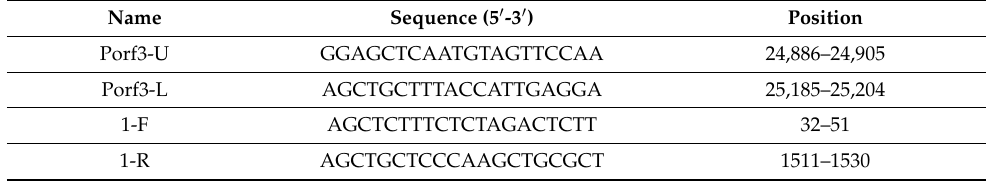
Table 1. Primers used for identifying and sequencing the PEDV SC-YB73